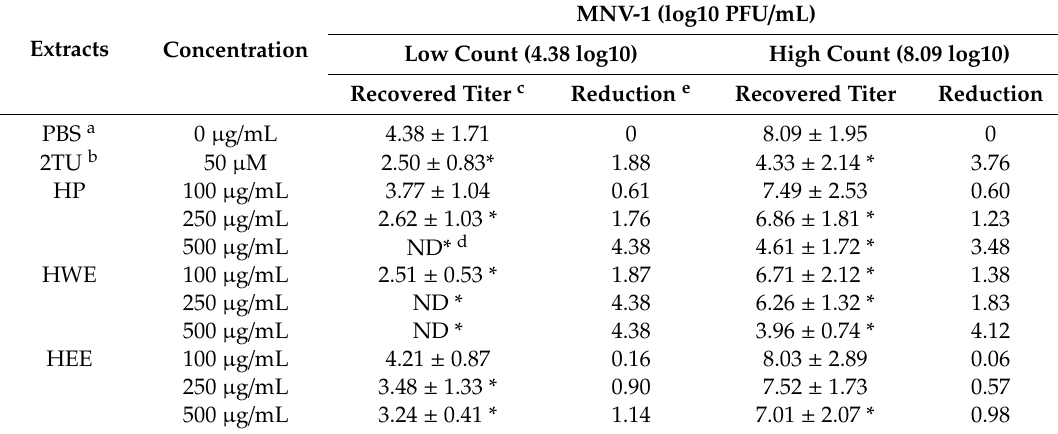
Table 4. E ff ects of HP, HWE, and HEE with low concentrations (4.38 log10 PFU / mL) and